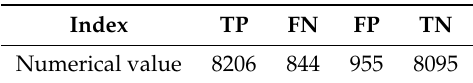
Table 24. Forecast indices